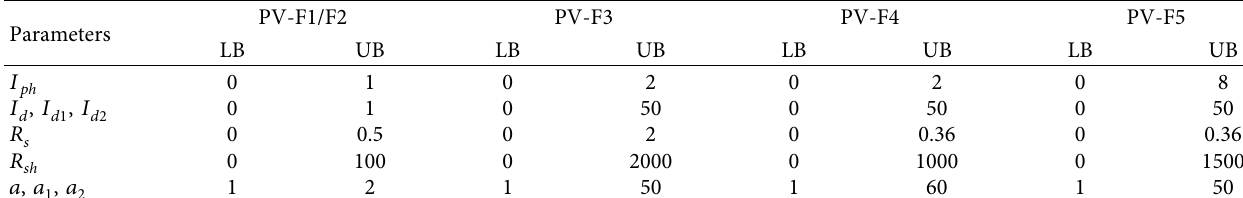
Table 5: The feasible range of parameters to be extracted.